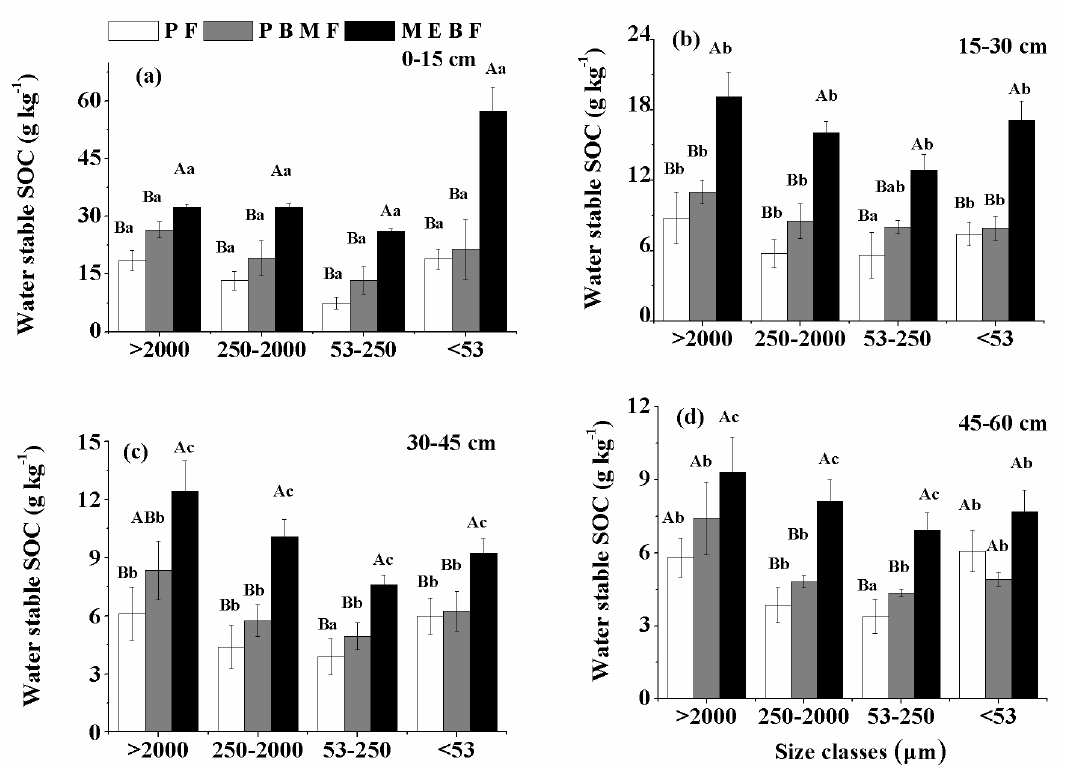
Figure 4. Sand-free soil organic carbon (SOC) concentration in all water-stable aggregate fractions in 0–15 cm ( a ); 15–30 cm ( b ); 30–45 cm ( c ); and 45–60 cm ( d ) in a forest succession. Error bars represent standard deviation. PF: pine forest; PBMF: pine and broadleaved mixed forest; MEBF: monsoon evergreen broadleaf forest. Different uppercase letters indicate significant differences between treatments at p < 0.05. For the same forest and aggregate fraction, different lowercase letters indicate significant differences between depths at p <